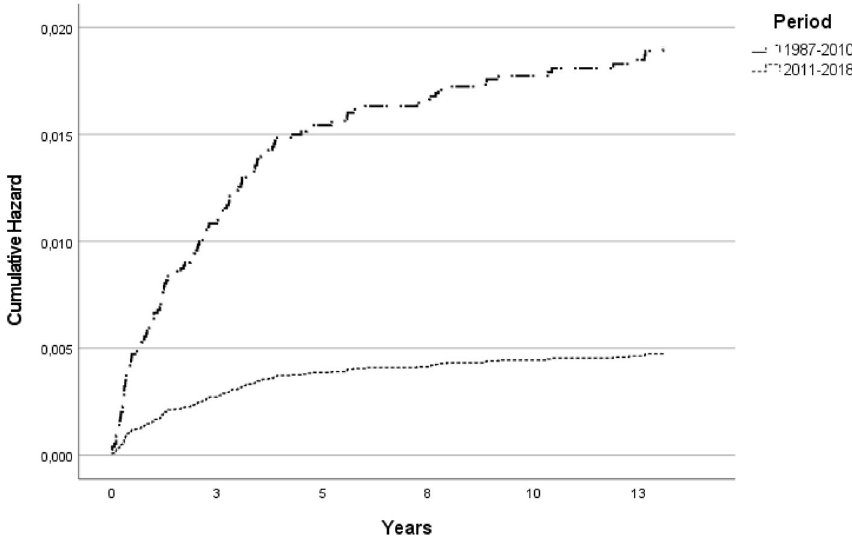
Figure 2. Risk function for the periods (1987–2010 and 2011–2018) according to Cox regression model adjusted for age, sex, BCG (scar and vaccination), consanguinity, type of household contact and classification form of index case. Cohort of contacts at the FIOCRUZ clinic,